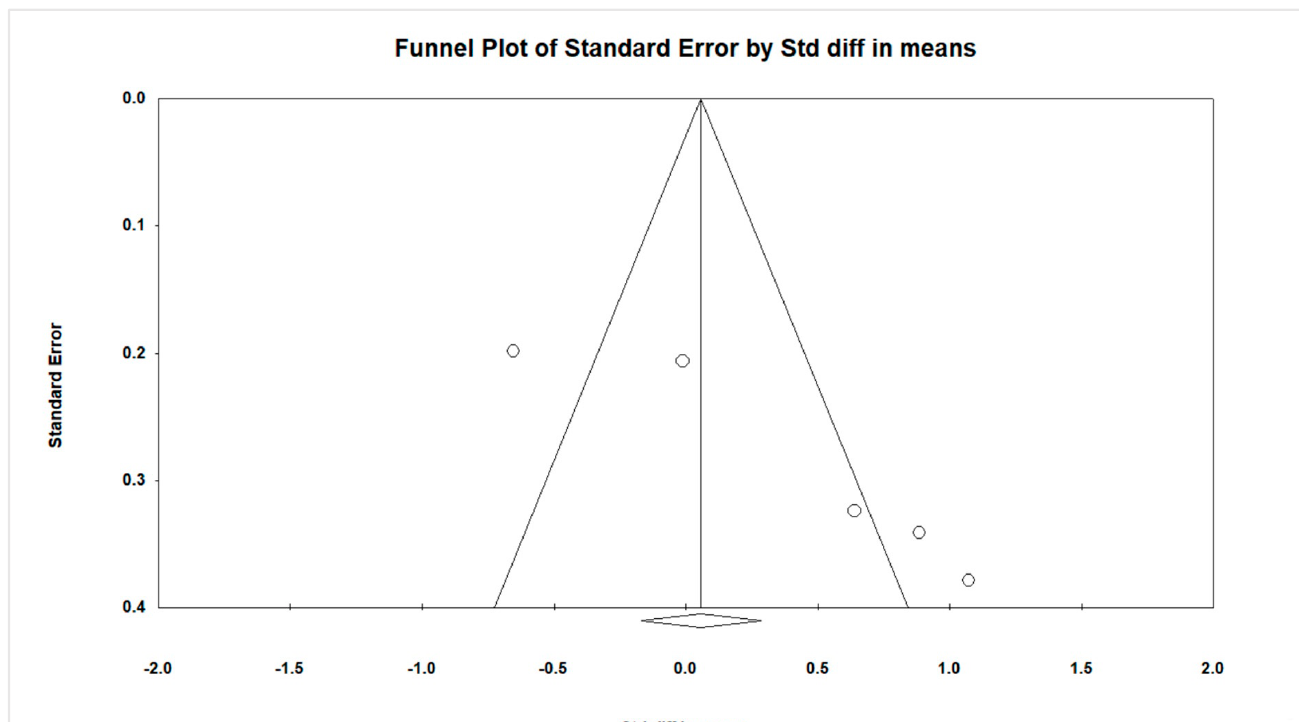
Figure A2. Funnel Plot.